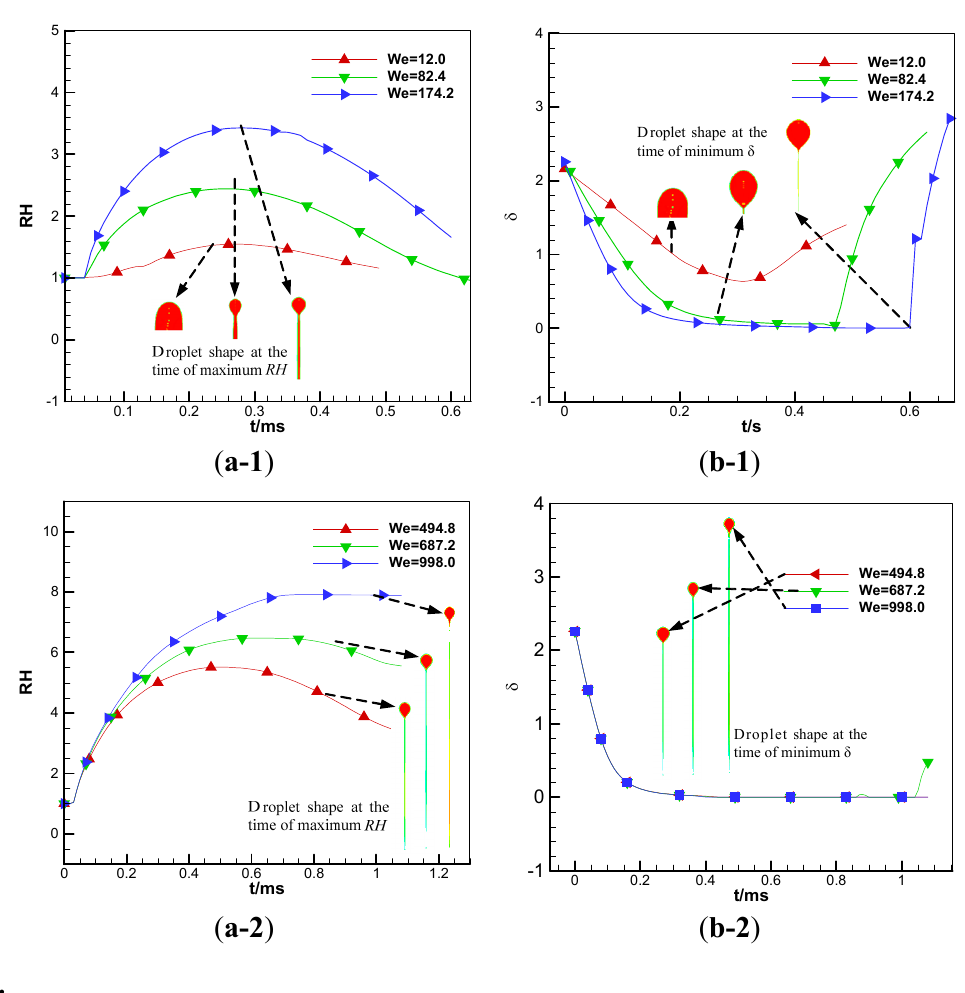
Figure 14. Time evolution of the dimensionless diameter RH ( a-1 , 2 ) and the dimensionless center thickness δ ( b-1 , 2